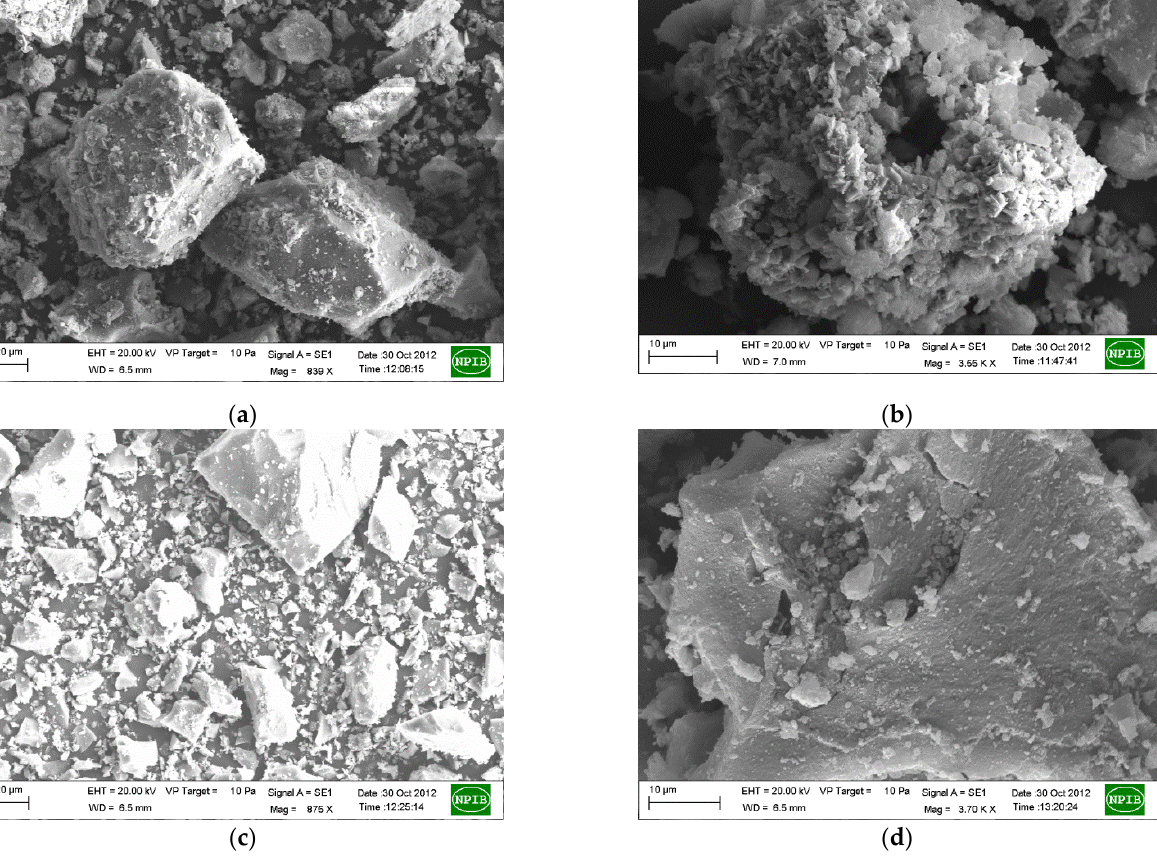
Figure 9. SEM images of the RMP1-500 ( a , b ) and RMP2-500 ( c , d ) samples.